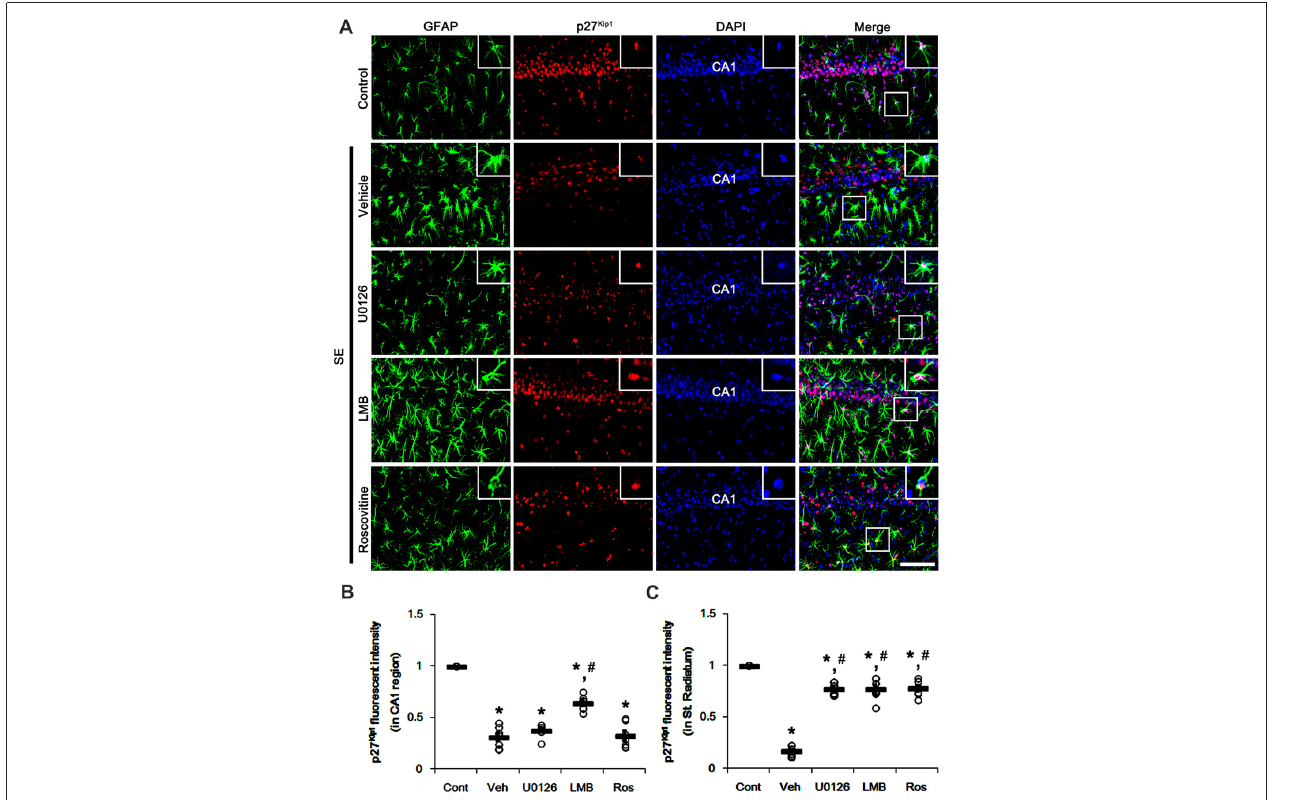
FIGURE 3 | Effects of U0126, LMB and roscovitine on p27 Kip1 expression in the CA1 region following SE. (A) Representative double immunofluorescent images for GFAP and p27 Kip1 expression. SE reduces nuclear p27 Kip1 expression in CA1 neurons as well as astrocytes. As compared to vehicle, LMB attenuates the decline of nuclear p27 Kip1 expression in CA1 neurons, while U0126 and roscovitine do not. However, U0126, LMB and roscovitine abrogate the decline of nuclear p27 Kip1 expression in astrocytes. Insert images are high magnification of rectangles in merge panels. Bar = 50 and 12.5 (inserts) µ m. (B,C) Quantifications of the number of nuclear p27 Kip1 expression in CA1 neuron (B) and astrocytes (C) . Open circles indicate each individual value. Horizontal bars indicate mean value. Error bars indicate SEM ( ∗ , # p < 0.05 vs. control and vehicle, respectively; n = 7,